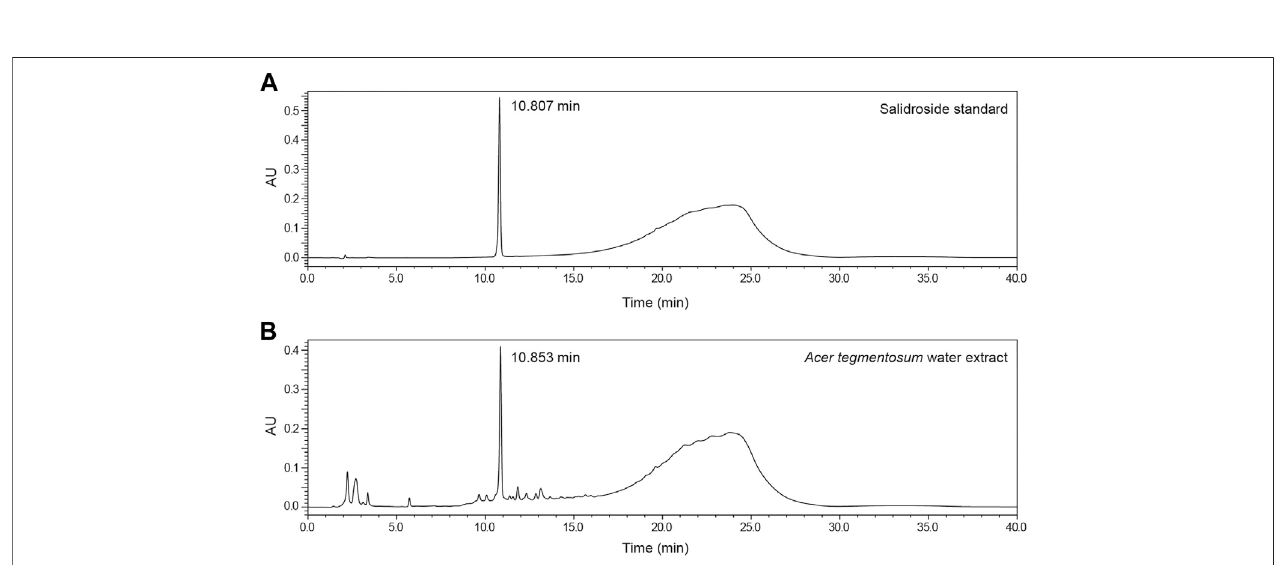
FIGURE 2 | Detection and quanti fi cation of salidroside in Acer tegmentosum Maxim. water extract. Representative HPLC chromatograms show (A) detection of the peak for salidroside at 10.807 min in the standard solution and (B) the HPLC pro fi le of Acer tegmentosum Maxim. water extract with salidroside detected at 10.853 min (see Materials and Methods for detailed analytical